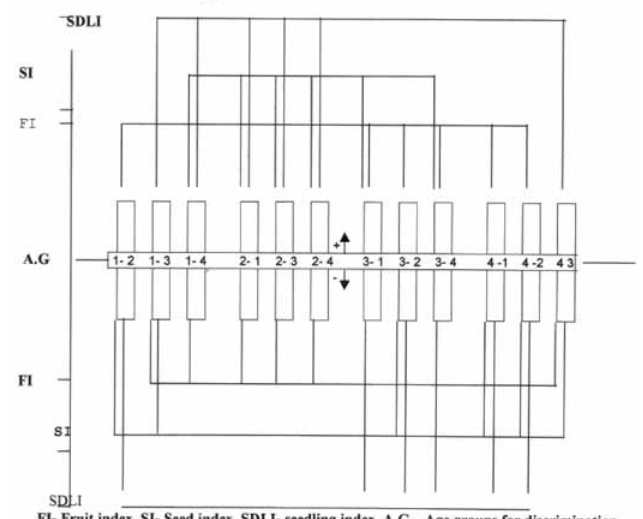
Fig. 7 - Dendrogram showing the directions of discriminant coefficients of fruit, seed and seedling indices of each age group when com- pared to the remaining three age groups in mangosteen ( Gar- cinia mangostana